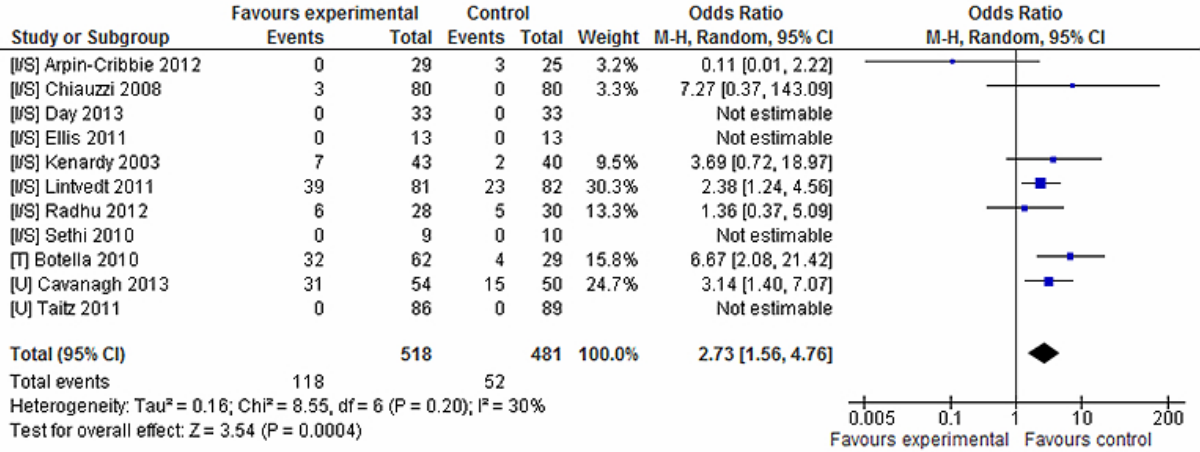
Figure 5. Attrition rates for intervention vs inactive control conditions.